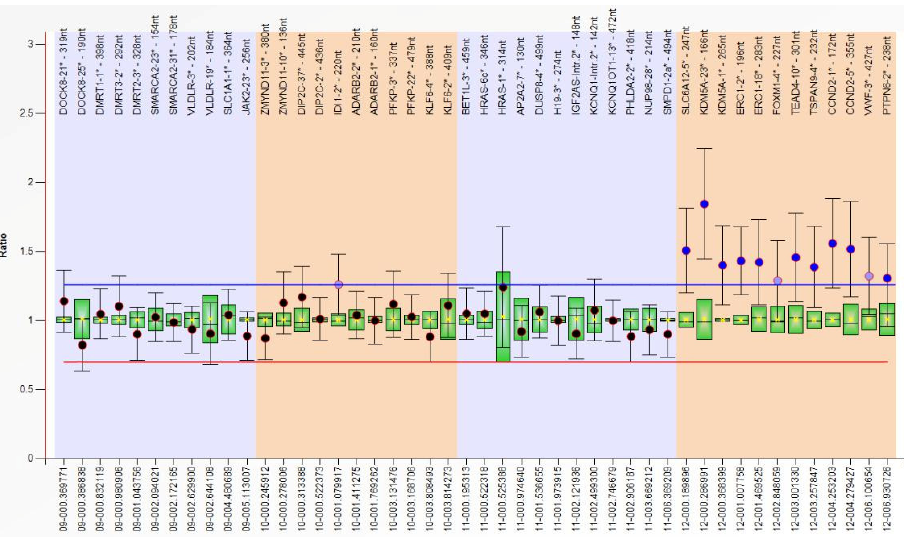
Figure 3. MLPA result for patient 1—DNA extracted from buccal